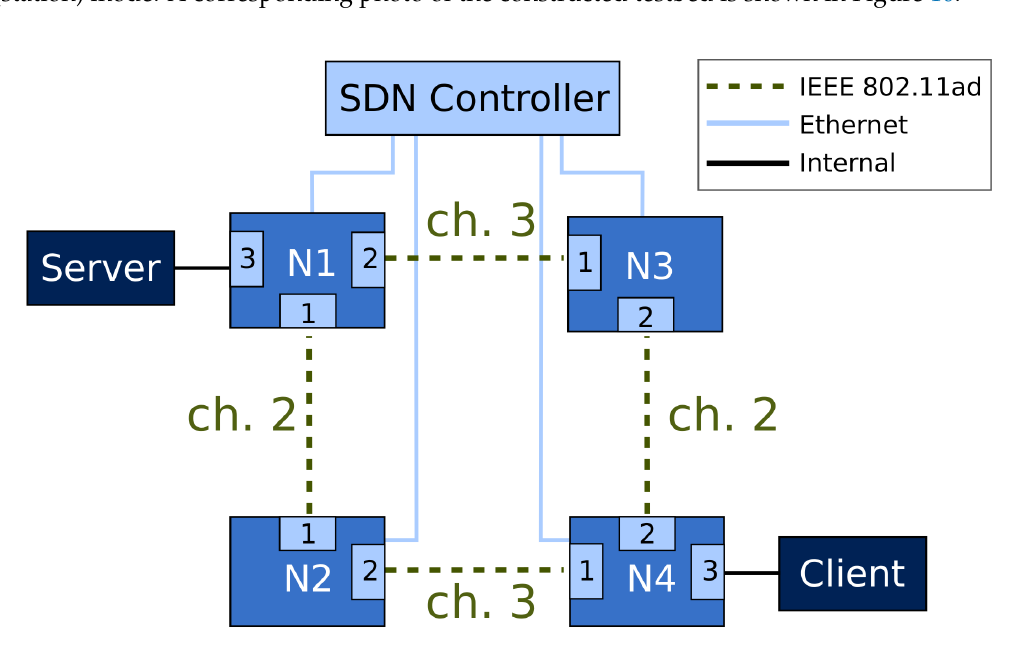
Figure 9. Used testbed